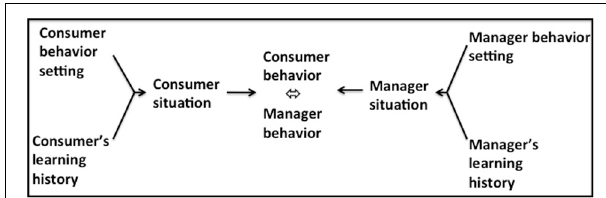
FIGURE 11 | Bilateral contingency between the individual manager and the individual